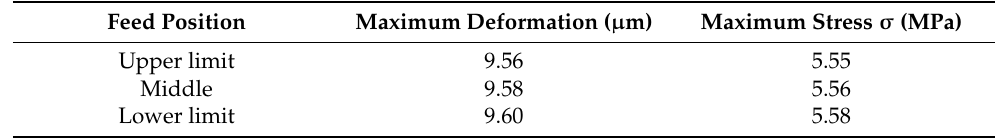
Table 2. Static deformation and stress of separate